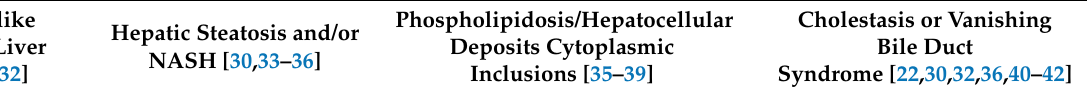
Table 1. Drugs inducing major types of chronic hepatocellular or cholestatic liver